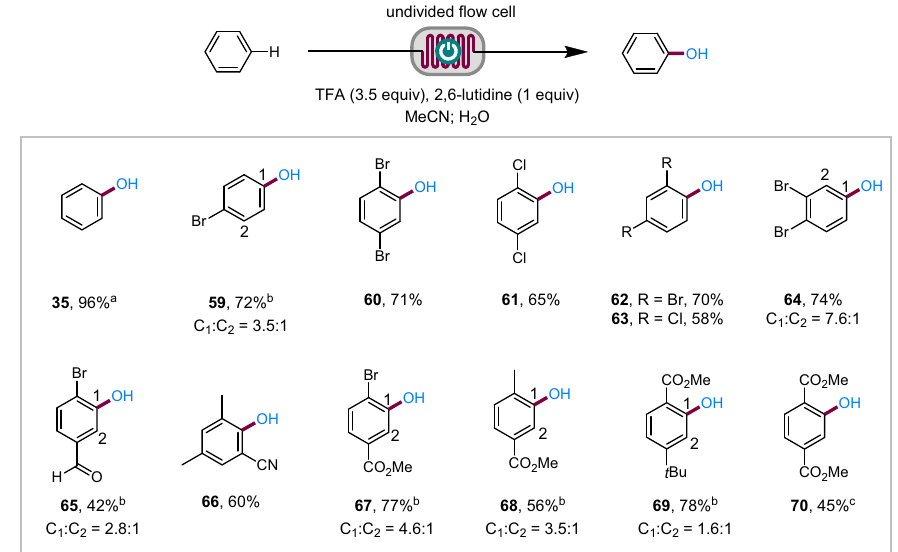
Fig. 3 Reaction scope of electron-de fi cient arenes. Regioisomers were not observed unless otherwise mentioned. Reaction conditions: Pt cathode and anode, constant current = 61 – 173 mA, 0.3 mL min − 1 . a Determined by GC analysis. b Regioisomers separated by fl ash chromatography. c Reaction in CH 2 Cl 2 in the presence of 6 equiv of TFA and 2 equiv of 2,6-lutidine.